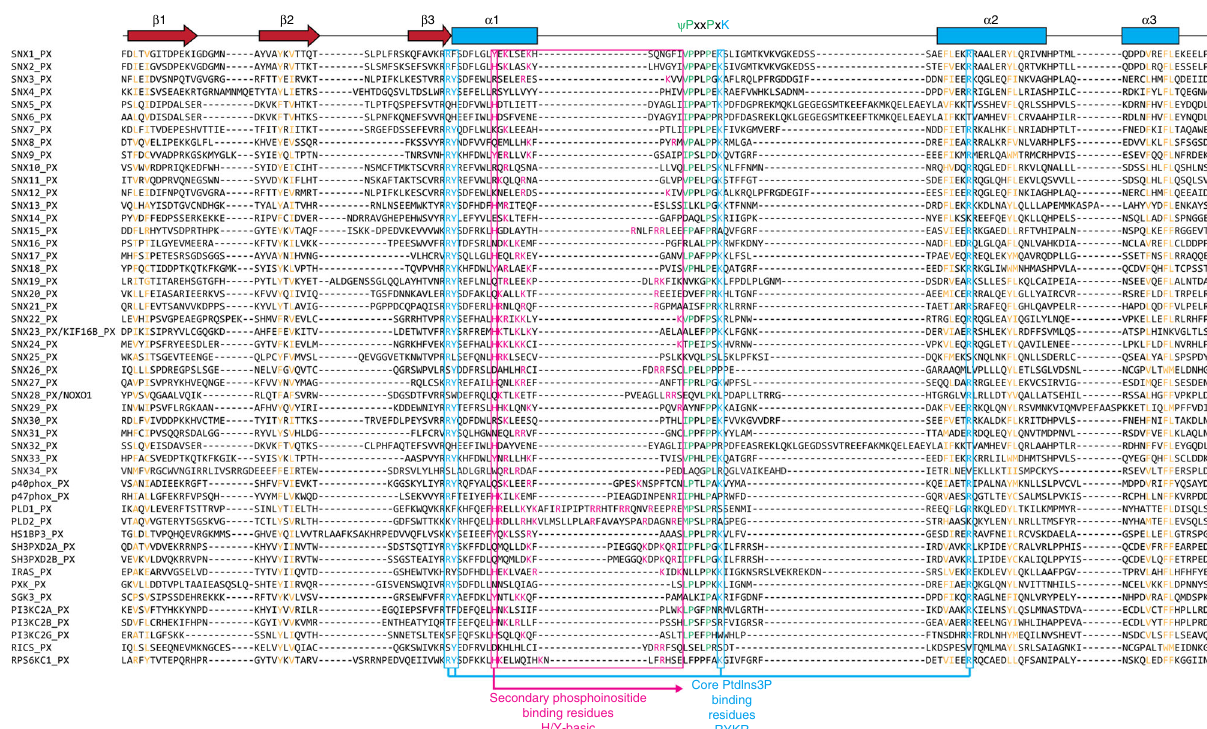
Fig. 4 Secondary structure-guided sequence alignment of the human PX domains. Amino acid sequence alignment of the human PX domains guided by secondary structure predictions de fi ned by PRALINE 51 . Where available, the precision of the sequence alignments was also manually curated by structural comparisons of the PX domains. As a reference, the secondary structure elements from the crystal structure of the PX domain of p40 phox are indicated at the top. The four critical residues involved in canonical phosphoinositide (PtdIns3 P ) recognition are shown in blue. The noncanonical phosphoinositide- binding residues are highlighted in magenta. These include either a His or Tyr at the fi rst position within helix α 1, followed by a stretch of basic Lys/Arg residues leading to the polyproline loop containing the Ψ PxxPxK sequence motif ( Ψ = hydrophobic side